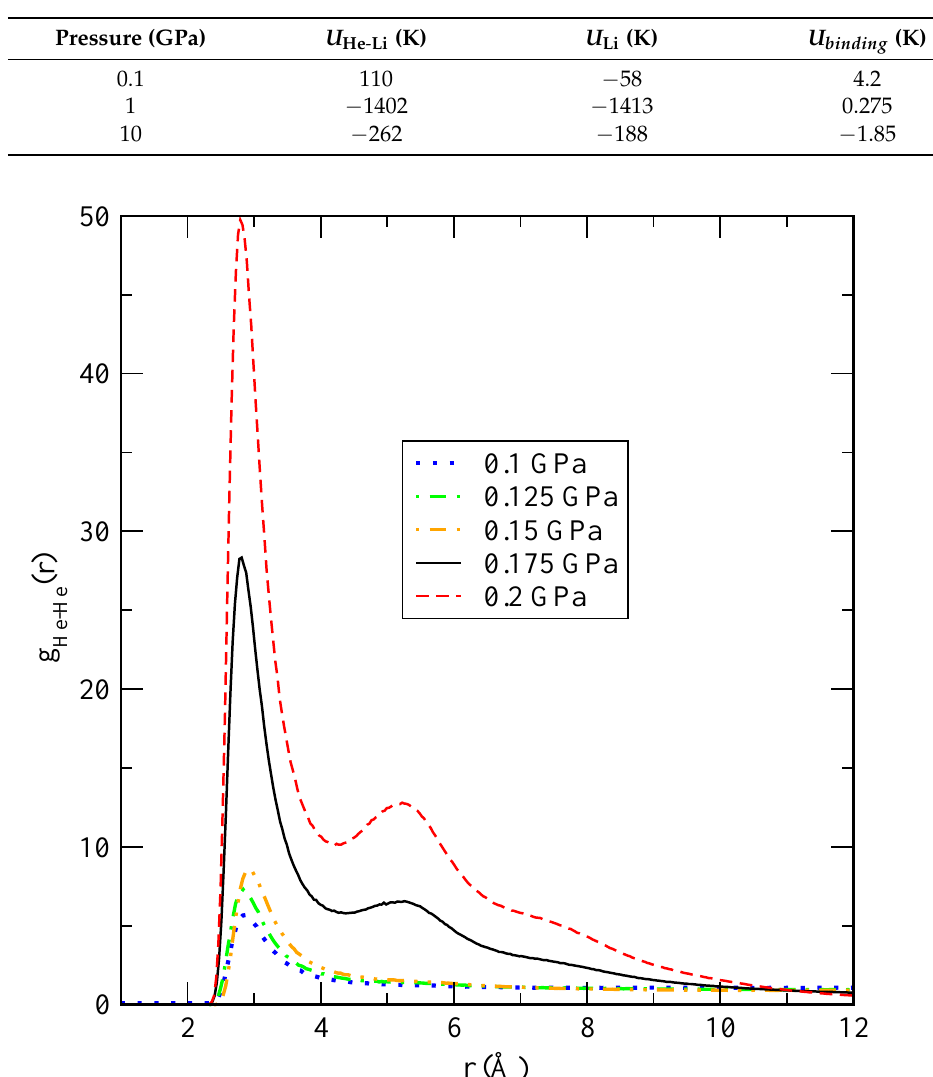
Figure 7. He-He pair distribution functions in the vicinity of the phase-separation transition (0.1–0.2 GPa). Lines: 0.1 GPa (dotted blue); 0.125 GPa (dot-dashed green); 0.15 GPa (dot-dot-dashed orange); 0.175 GPa (black); 0.2 GPa (dashed